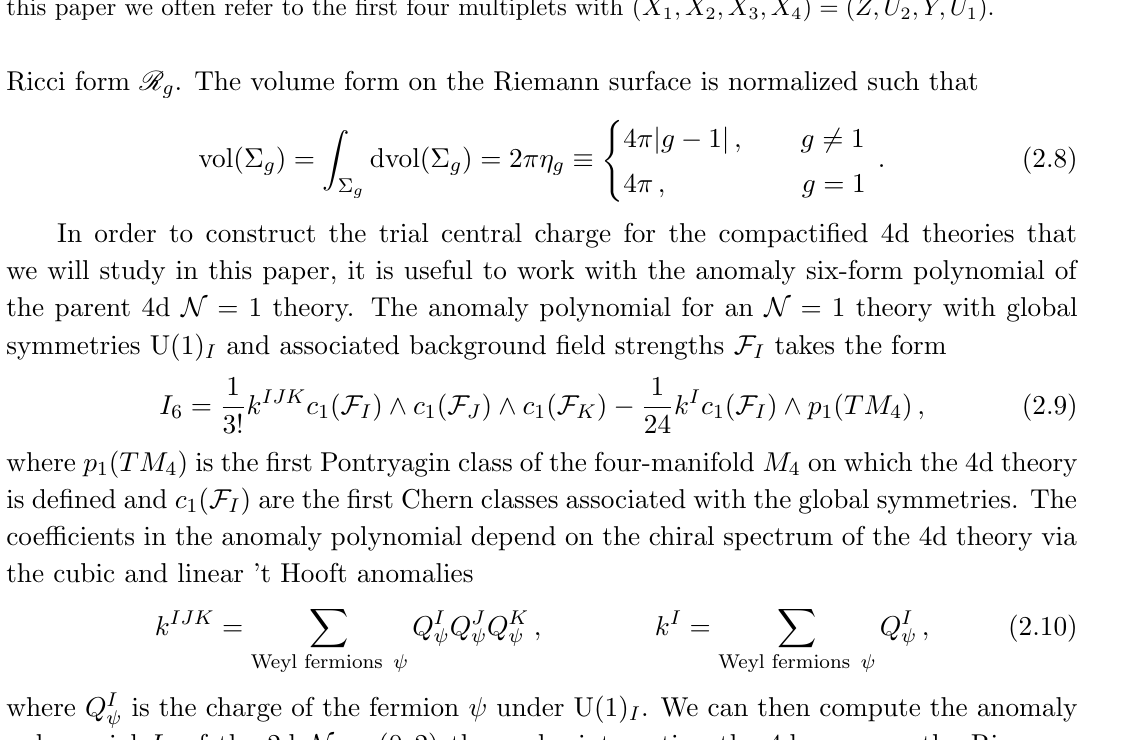
Table 1 . Bifundamental matter and vector multiplets in the L a;b;c quiver and their charges. In this paper we often refer to the (cid:12)rst four multiplets with ( X 1 ; X 2 ; X 3 ; X 4 ) = ( Z; U 2 ; Y; U 1